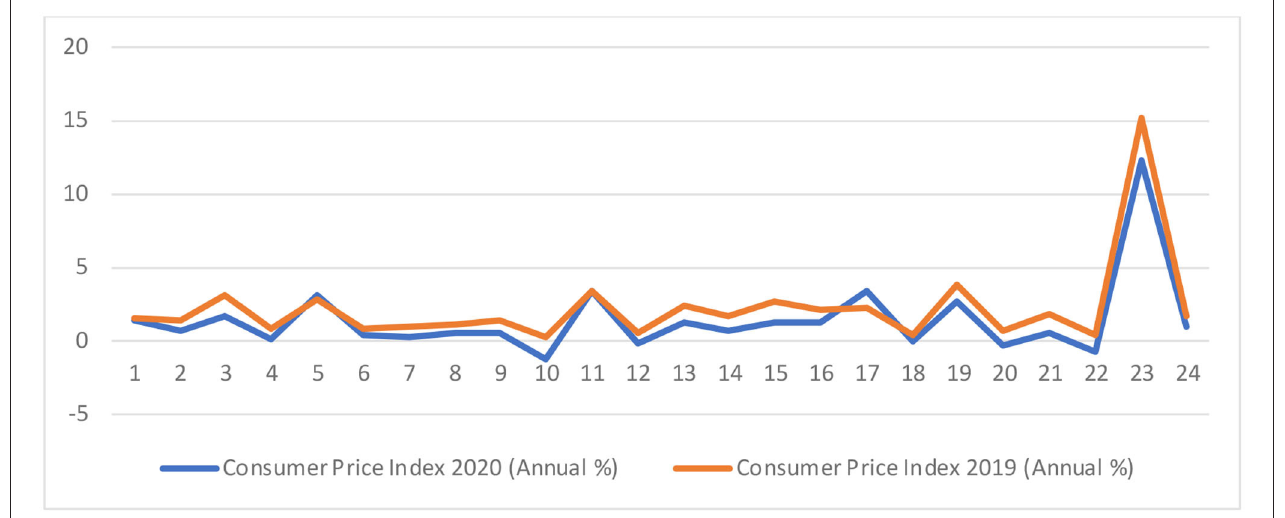
FIGURE 3 | Comparative analysis of consumer price index (CPI) 2020 and CPI 2019. Source: Author’s Calculations.